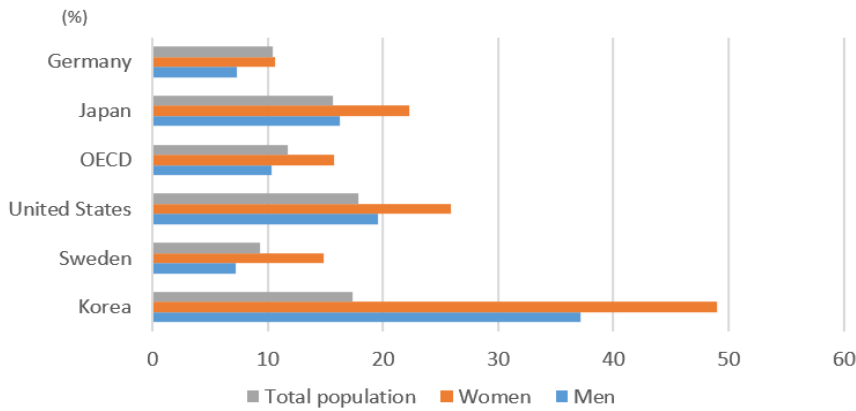
Figure 5. Poverty rate by gender (2016). Source: OECD [6].